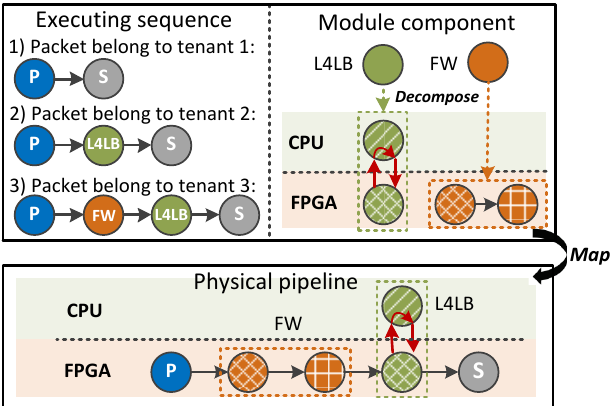
Figure 3. The NF developer specifies the module execution sequence for each type of packets. We need to decompose NFs and map them to one physical pipeline according to module execution